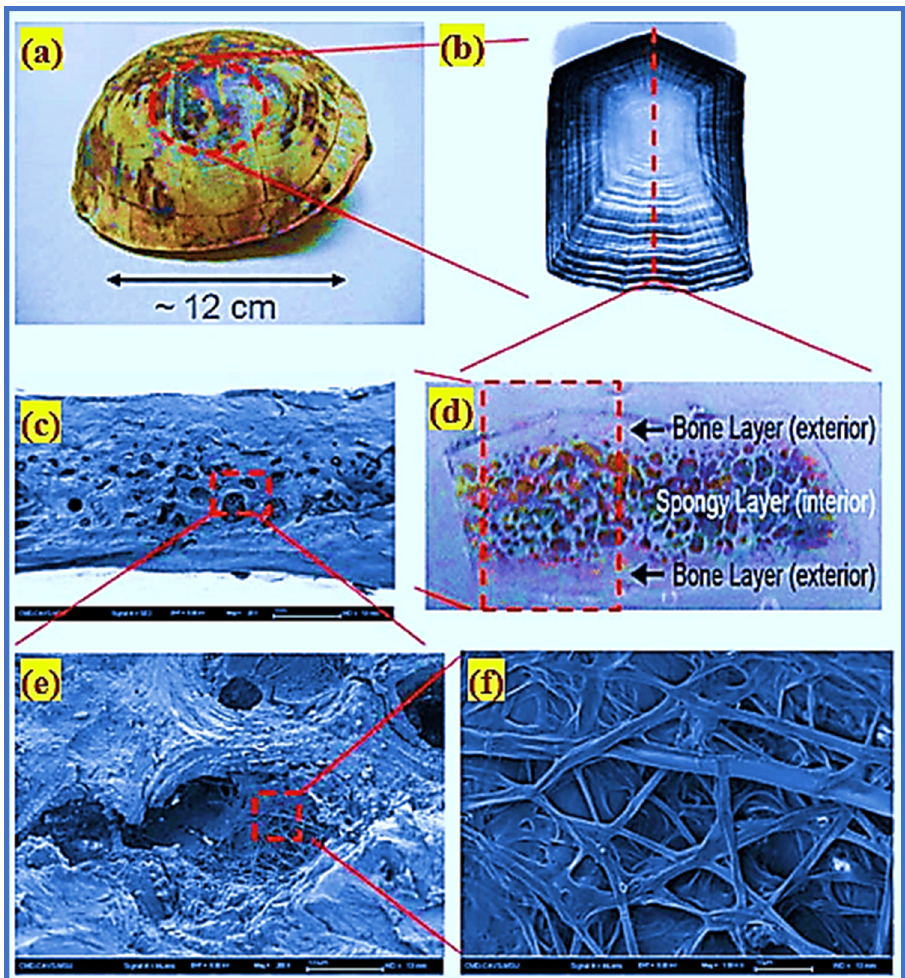
Figure 1. The structure of turtle shell and its multiscale hierarchy: ( a ) a morphology of the shell structure of turtle; ( b ) a costal scute indicating the sequent pattern of growth pattern; ( c ) scanning electron microscope image of the fractured surface; ( d ) a cross-section of carapace displaying a composite layer; ( e ) scanning electron microscope image of the cell structure; and ( f ) scanning electron microscope image of the interior fibrous structure of the cell. .